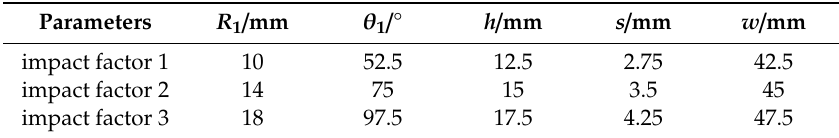
Table 2. Parameters to be optimized and impact